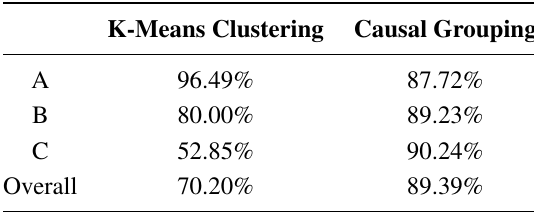
Table 6. The classification accuracy for the roundabout dataset.